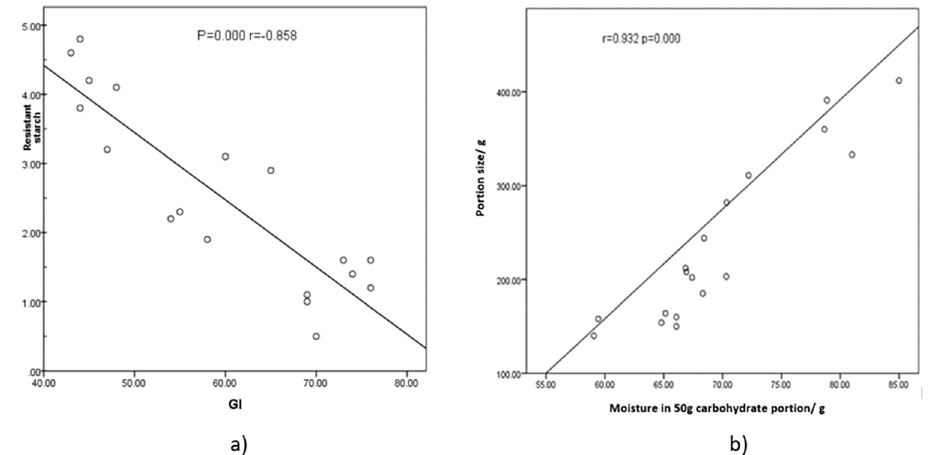
Fig 4. Correlation between a) Glycaemic index and resistant starch content in the portion given to study the glycaemic index b) Moisture content in the portion given to study the glycaemic index and the portion